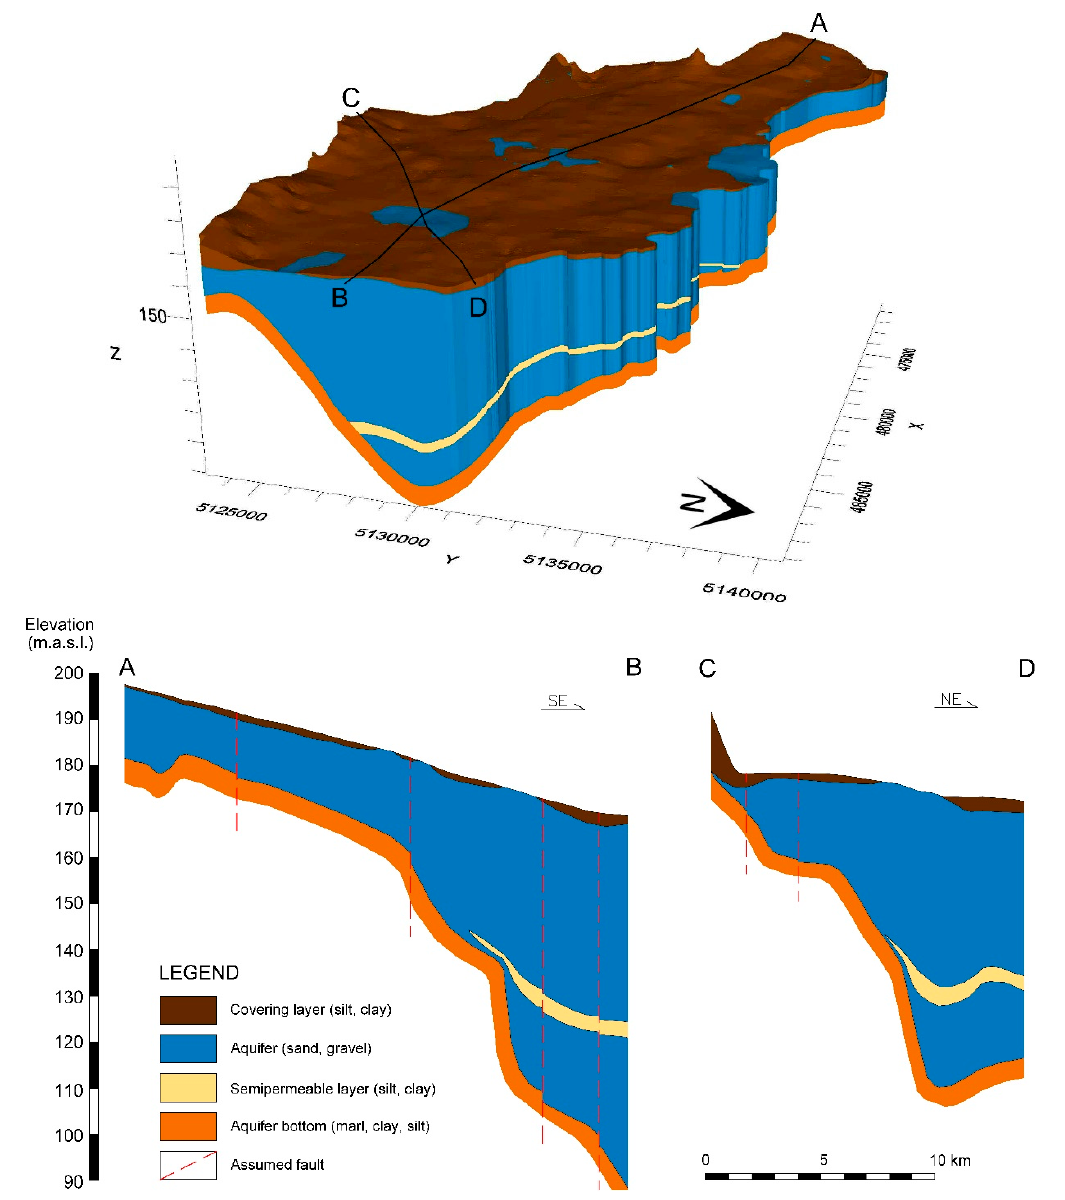
Figure 4. 3D model of the Varaždin alluvial aquifer with representative hydrogeological cross-sections.